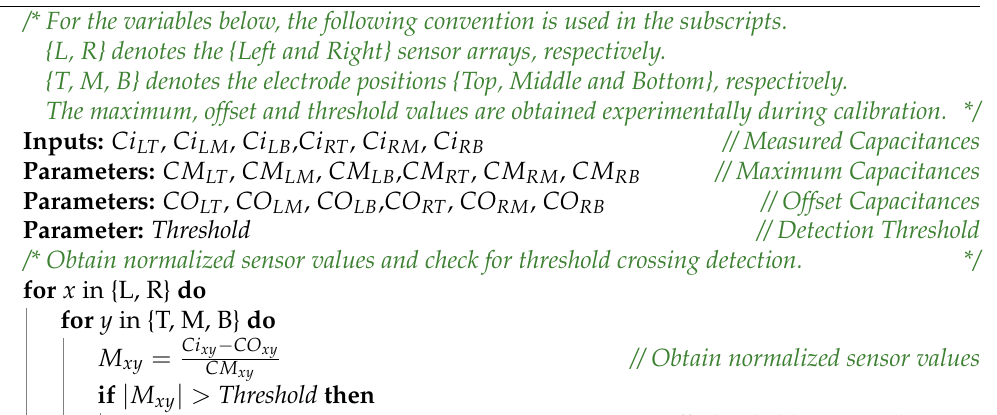
Algorithm 1 Grasp Detection